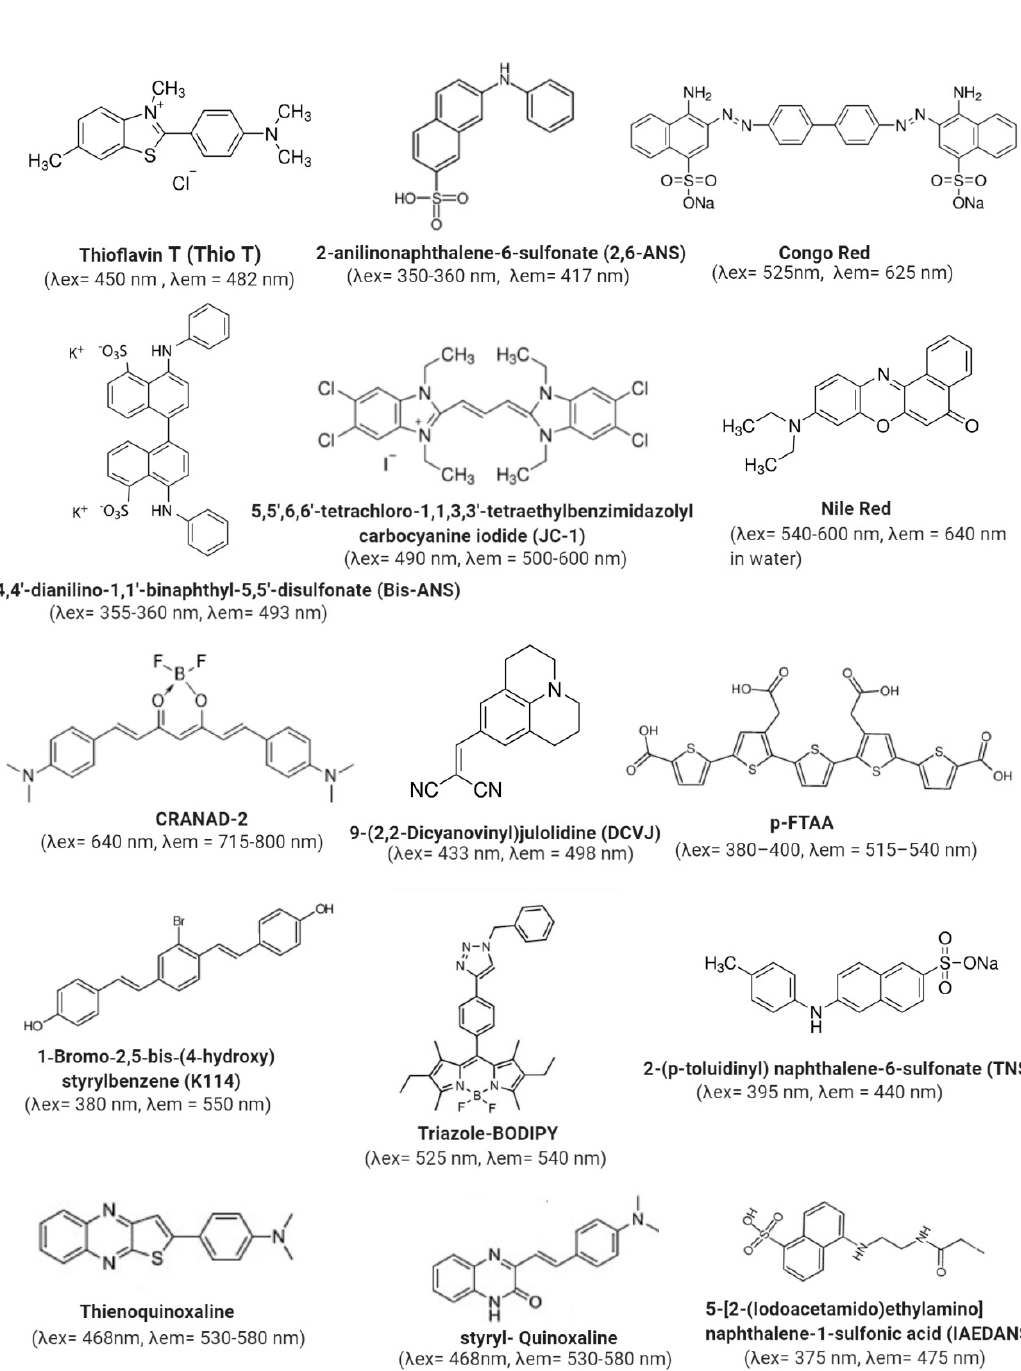
Figure 8. Structure of selected extrinsic fluorescent probes used to evaluate the self-assembly and aggregation of proteins and peptides. Image created with Biorender.com.